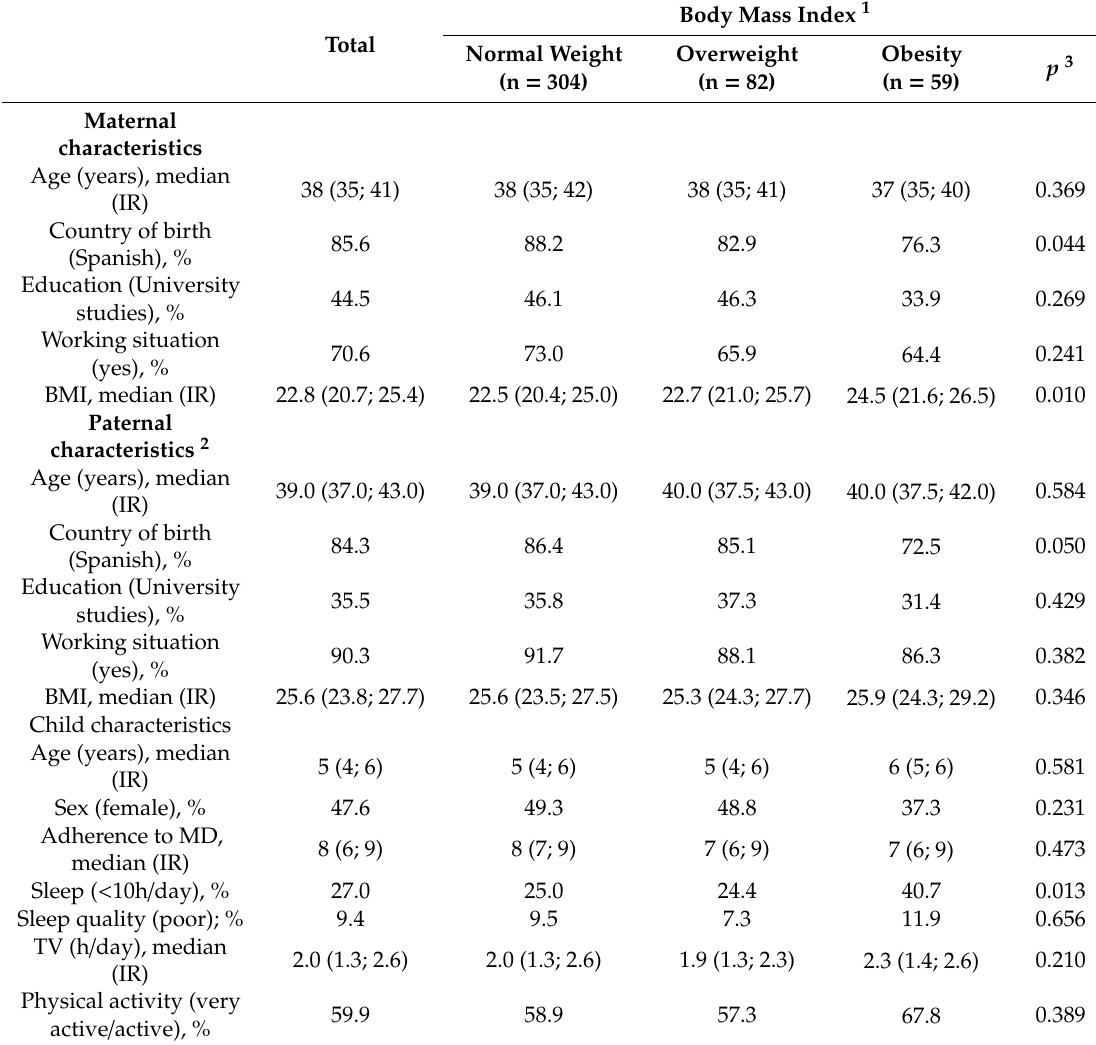
Table 1. Demographic and lifestyle characteristics according to the child body mass index categories of the participants in the InProS Project ( n =